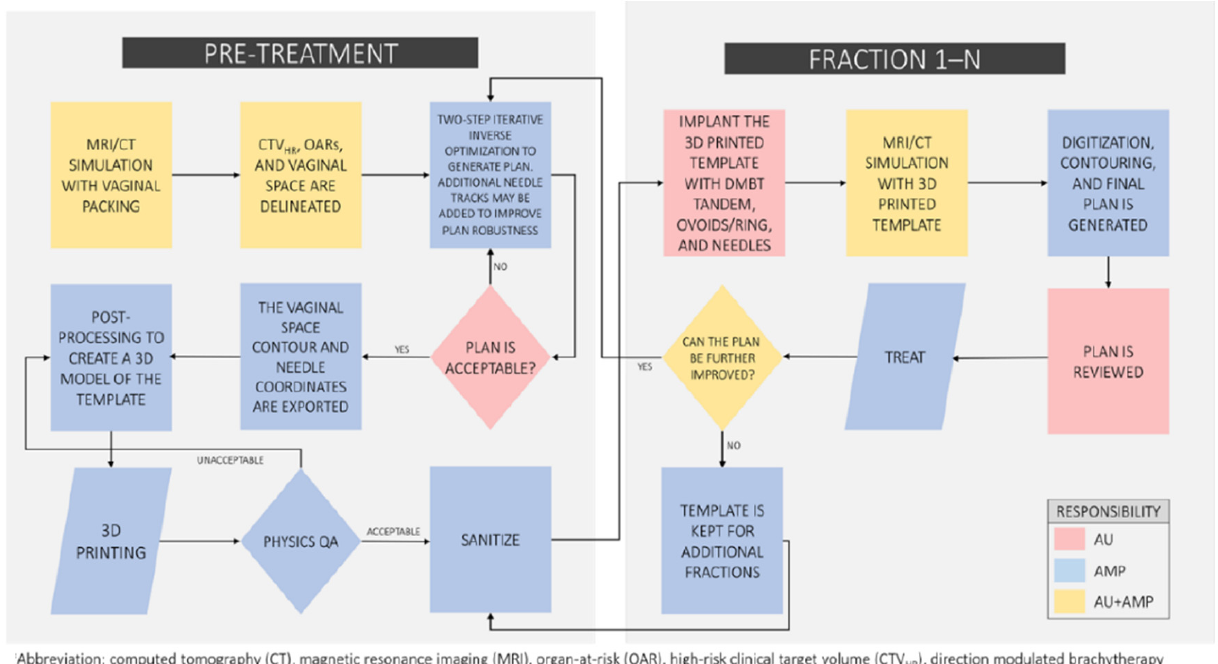
Figure 2. The proposed workflow with identified personnel to perform each step.